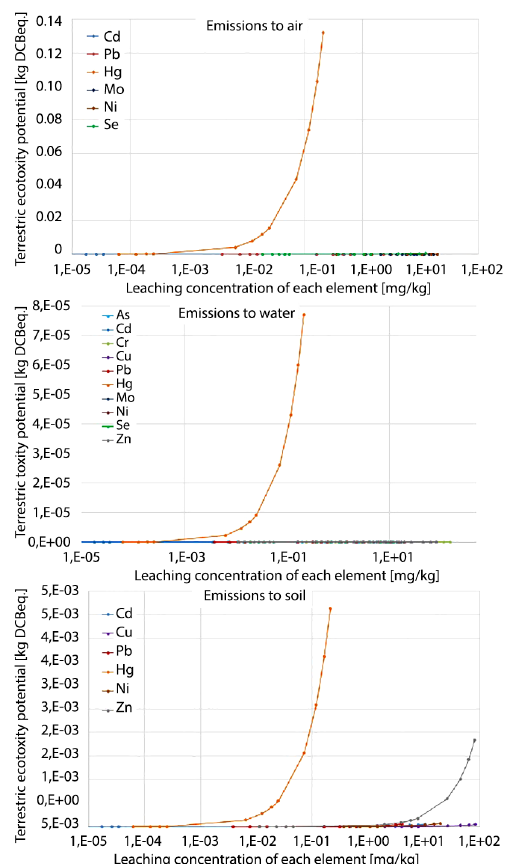
Figure 6. LCA model results – TETP dependence on leaching concentrations of selected heavy metals